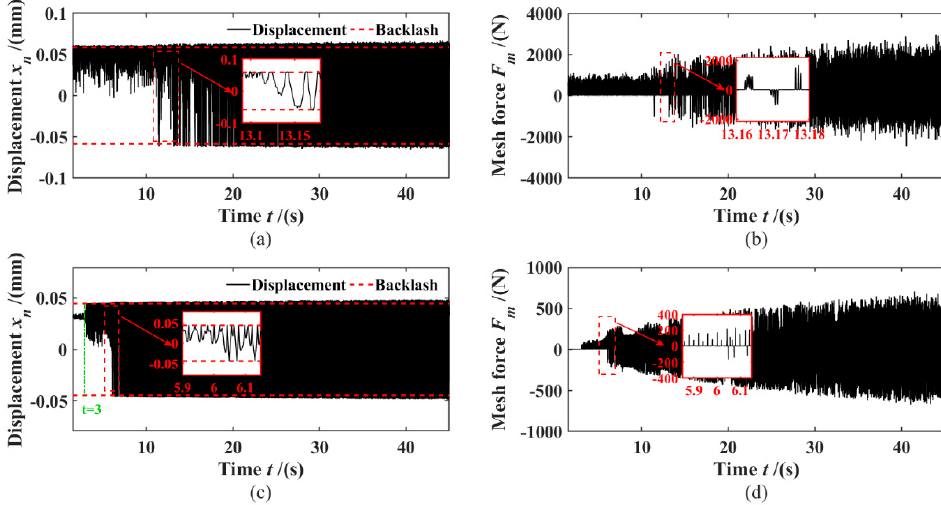
placement; (d) 3rd gear meshing force;